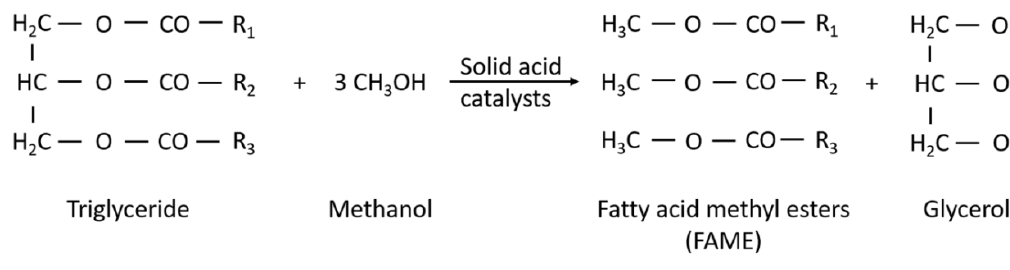
Figure 1. Solid acid-catalyzed transesterification reaction.